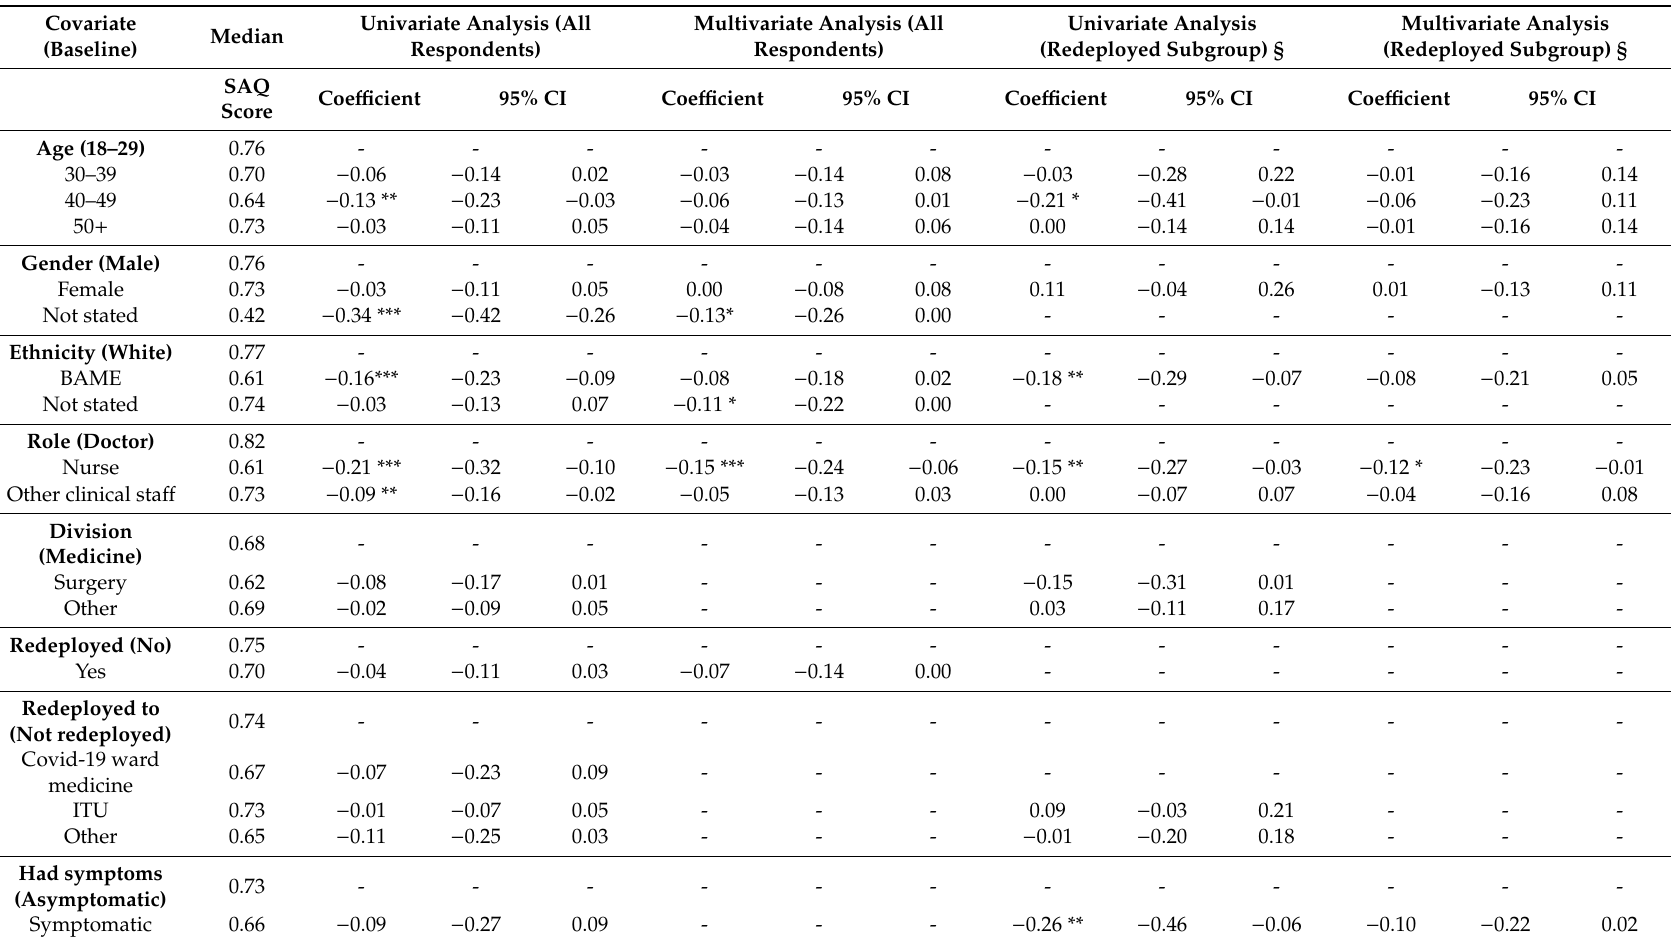
Table 2. Quantile regression of SAQ scores during the Covid-19